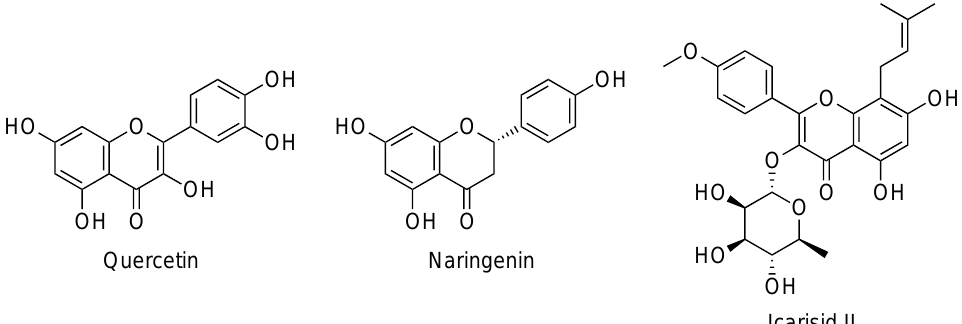
Figure 4. Chemical structures of quercetin, naringenin and icarisid II, representative flavonoids studied in the cited research works.